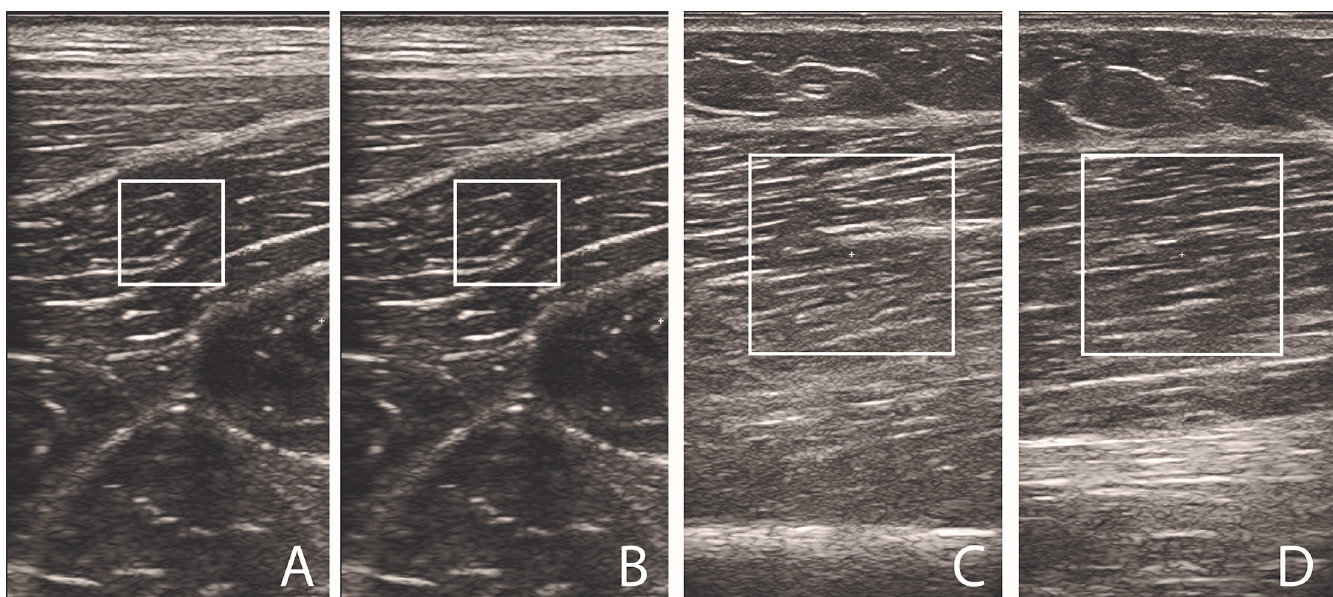
Fig 2. Examples of typical region of interest positioning. Low and high force application conditions resulted in minimal (i.e. visually undetectable) changes in the image (A and B). Images C and D show examples of region of interest positioning on a selected human participant for relaxed and stretched condition, respectively.